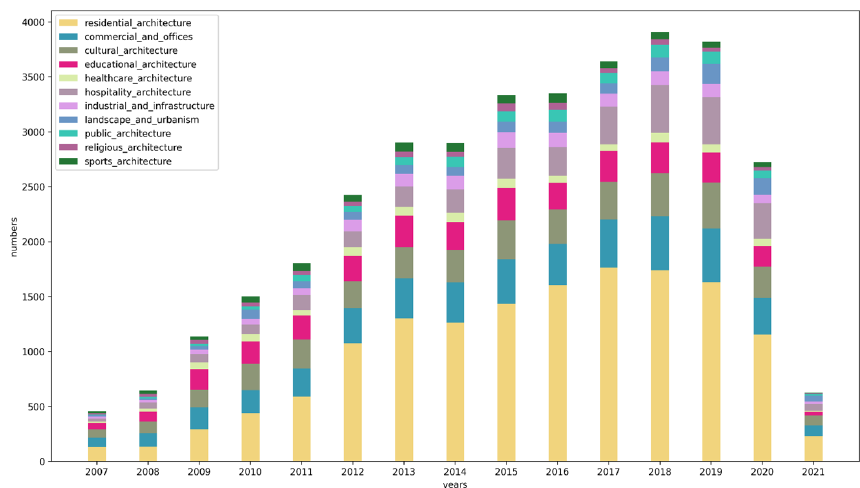
Figure 4. The number of projects involving each building type from 2007 to